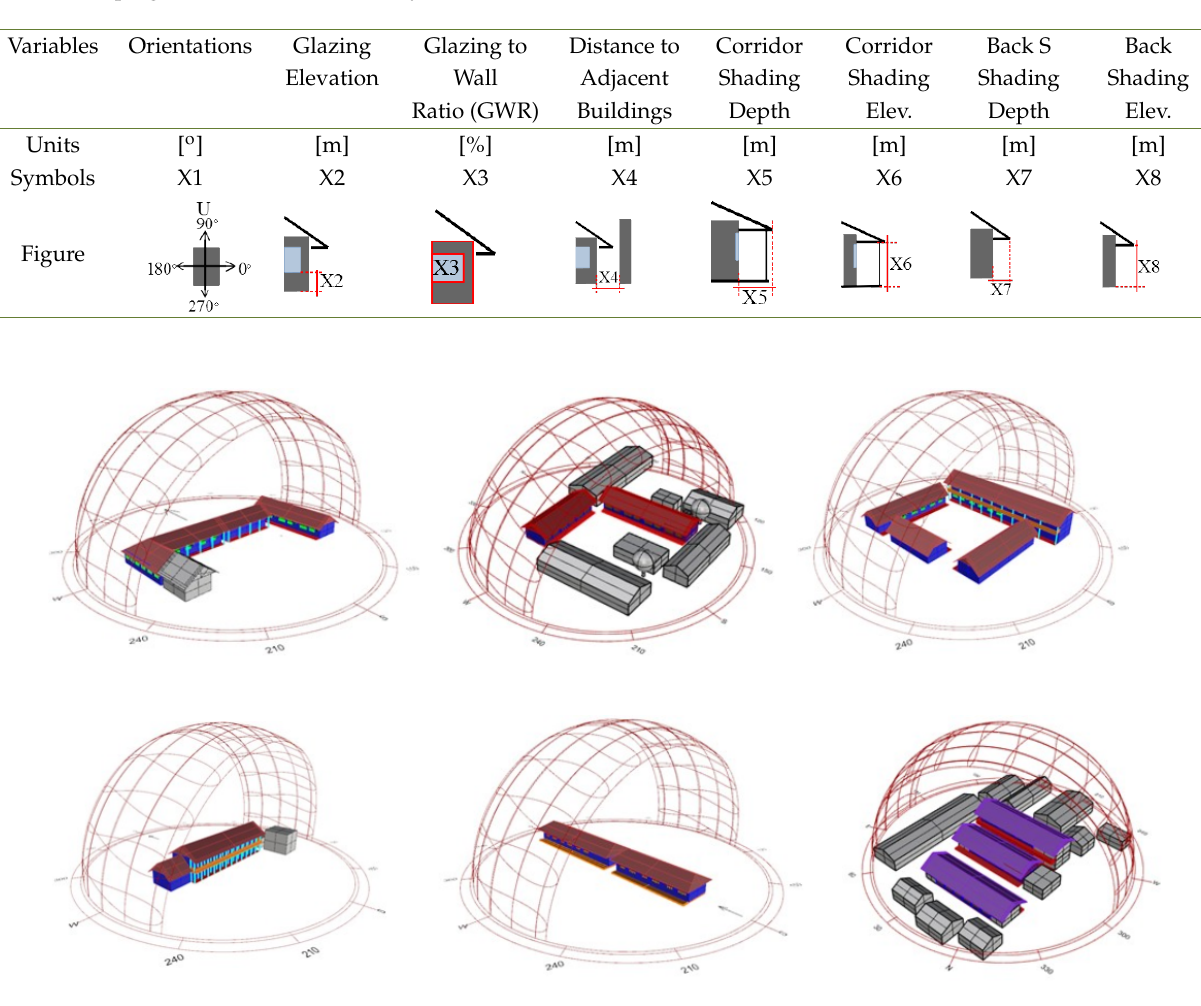
Table 1. Grouping variables, its units, and symbols.